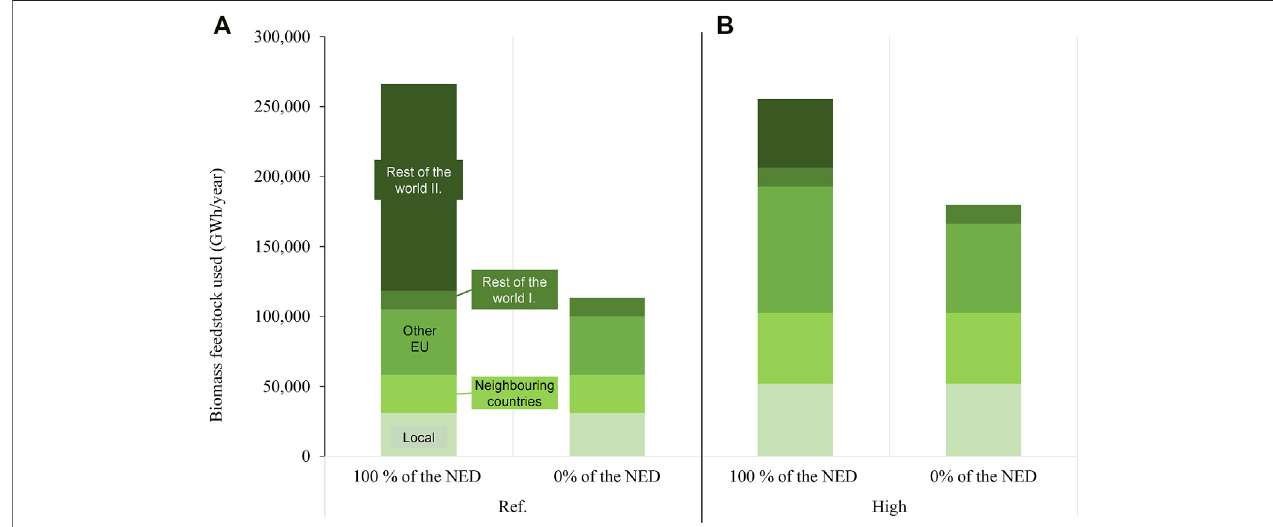
FIGURE 7 | Lignocellulosic biomass feedstock used divided by origin with and without the non-energy demand (NED) for cases with GHG savings of 90%, for the reference (A) and high (B) potential scenarios.